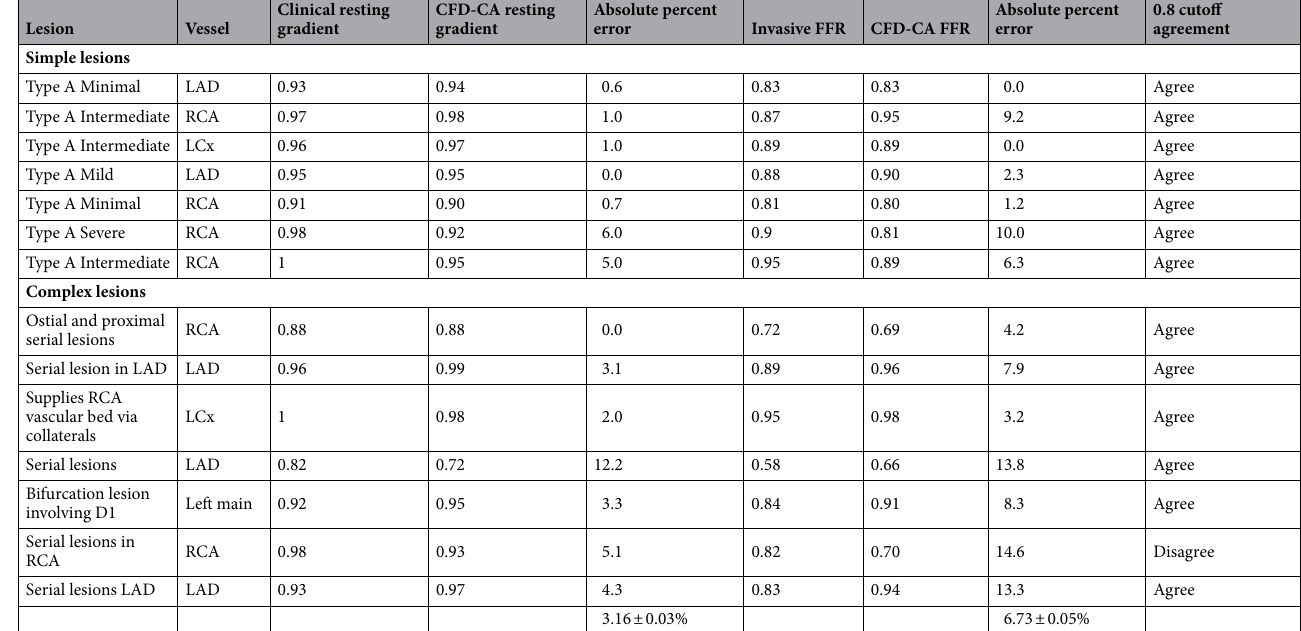
Table 1. Validating CFD-CA derived FFR by comparing to invasively measured FFR. Left anterior descending: LAD, left circumflex: LCx, right coronary artery: RCA, diagonal 1: D1. Minimal stenoses: